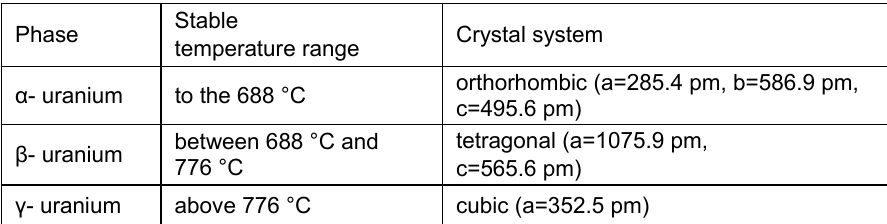
Table 1 - Modifications of uranium at atmospheric